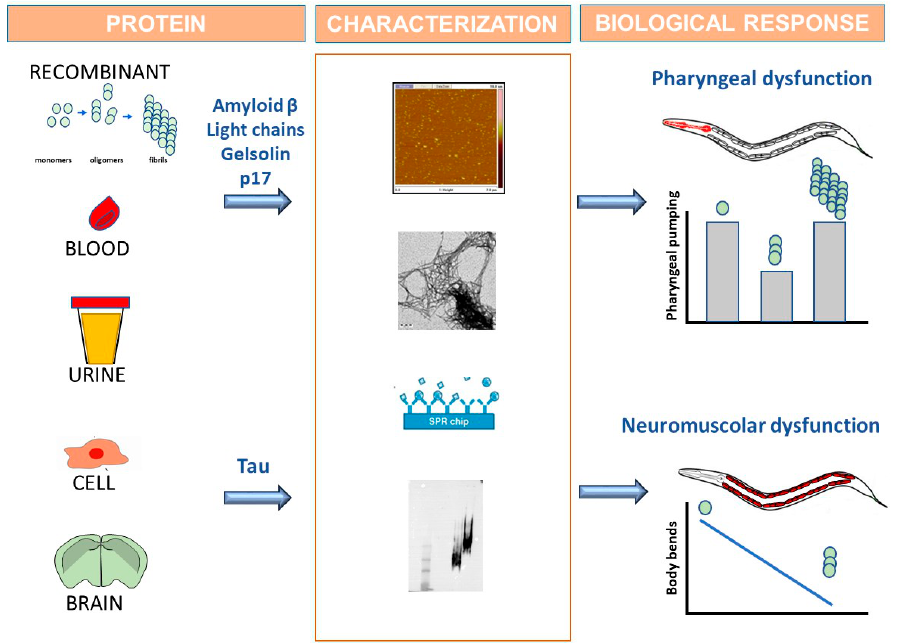
Figure 1. C. elegans use as biosensor able to recognize the toxic forms of amyloidogenic proteins by developing specific behavioral dysfunctions. Amyloidogenic proteins are obtained by recombinant production or purified from the tissues of transgenic animals or diseased patients. Homogenates from cells expressing human amyloidogenic proteins or brains from animals modelling amyloidosis can also be employed as protein source. The conformational state of the proteins must be characterized by employing biophysical and biochemical methods (i.e., atomic force microscopy, electron microscopy, surface plasmon resonance, native and denaturing gels). Proteins are administered to worms and alterations in the C. elegans behavior are then assayed to monitor the onset of proteotoxicity in vivo. Data obtained with synthetic amyloid β peptides, recombinant gelsolin, human immunodeficiency virus type-1 matrix protein p17 (p17) and amyloidogenic light chains purified from the blood or urine of patients with light chain amyloidosis, showed that the soluble oligomeric assemblies of these proteins, but not monomers and fibrils, caused a pharyngeal dysfunction in worms. The administration to nematodes of recombinant wild-type tau or tau in which proline at position 301 is substituted with lysine, as well as mutated protein from brain homogenates of transgenic mice, causes a neuromuscular dysfunction.